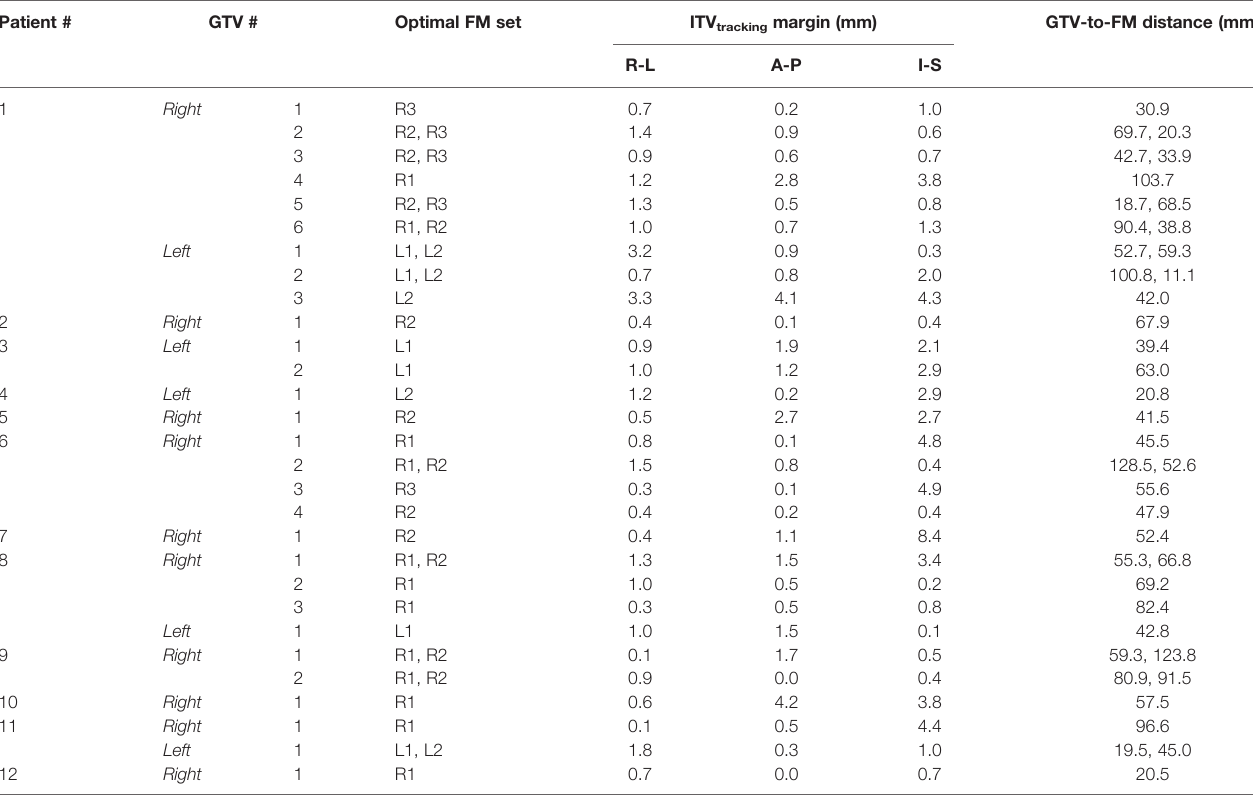
TABLE 2 | Summary of the ITV tracking determination results for each of the 42 lung lesions for 17 patients. Patient